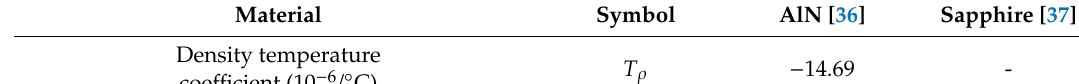
T ρ − 14.69 - T C 0.8 − 0.75 11 T C 1.8 0.4 12 T C 1.6 − 0.8 13 T C 14 0.5 − 1.8 T ε 11